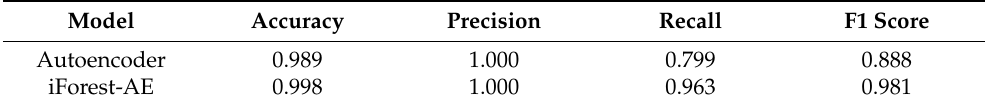
Table 3. Comparison of test results.